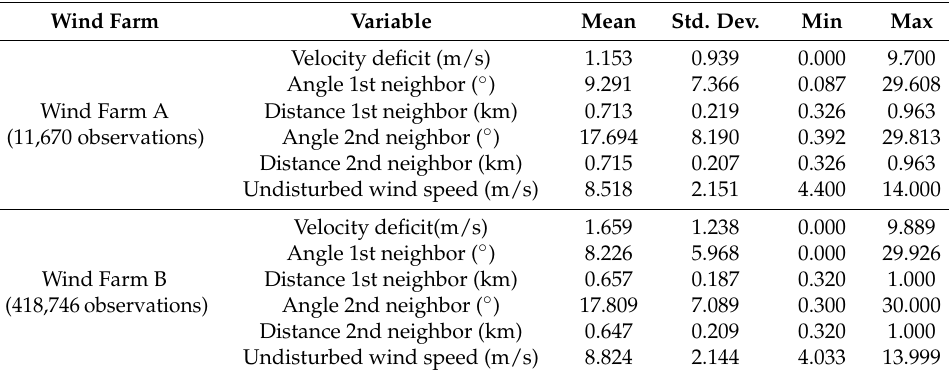
Table 2. Summary statistics of the wind farm data used in the